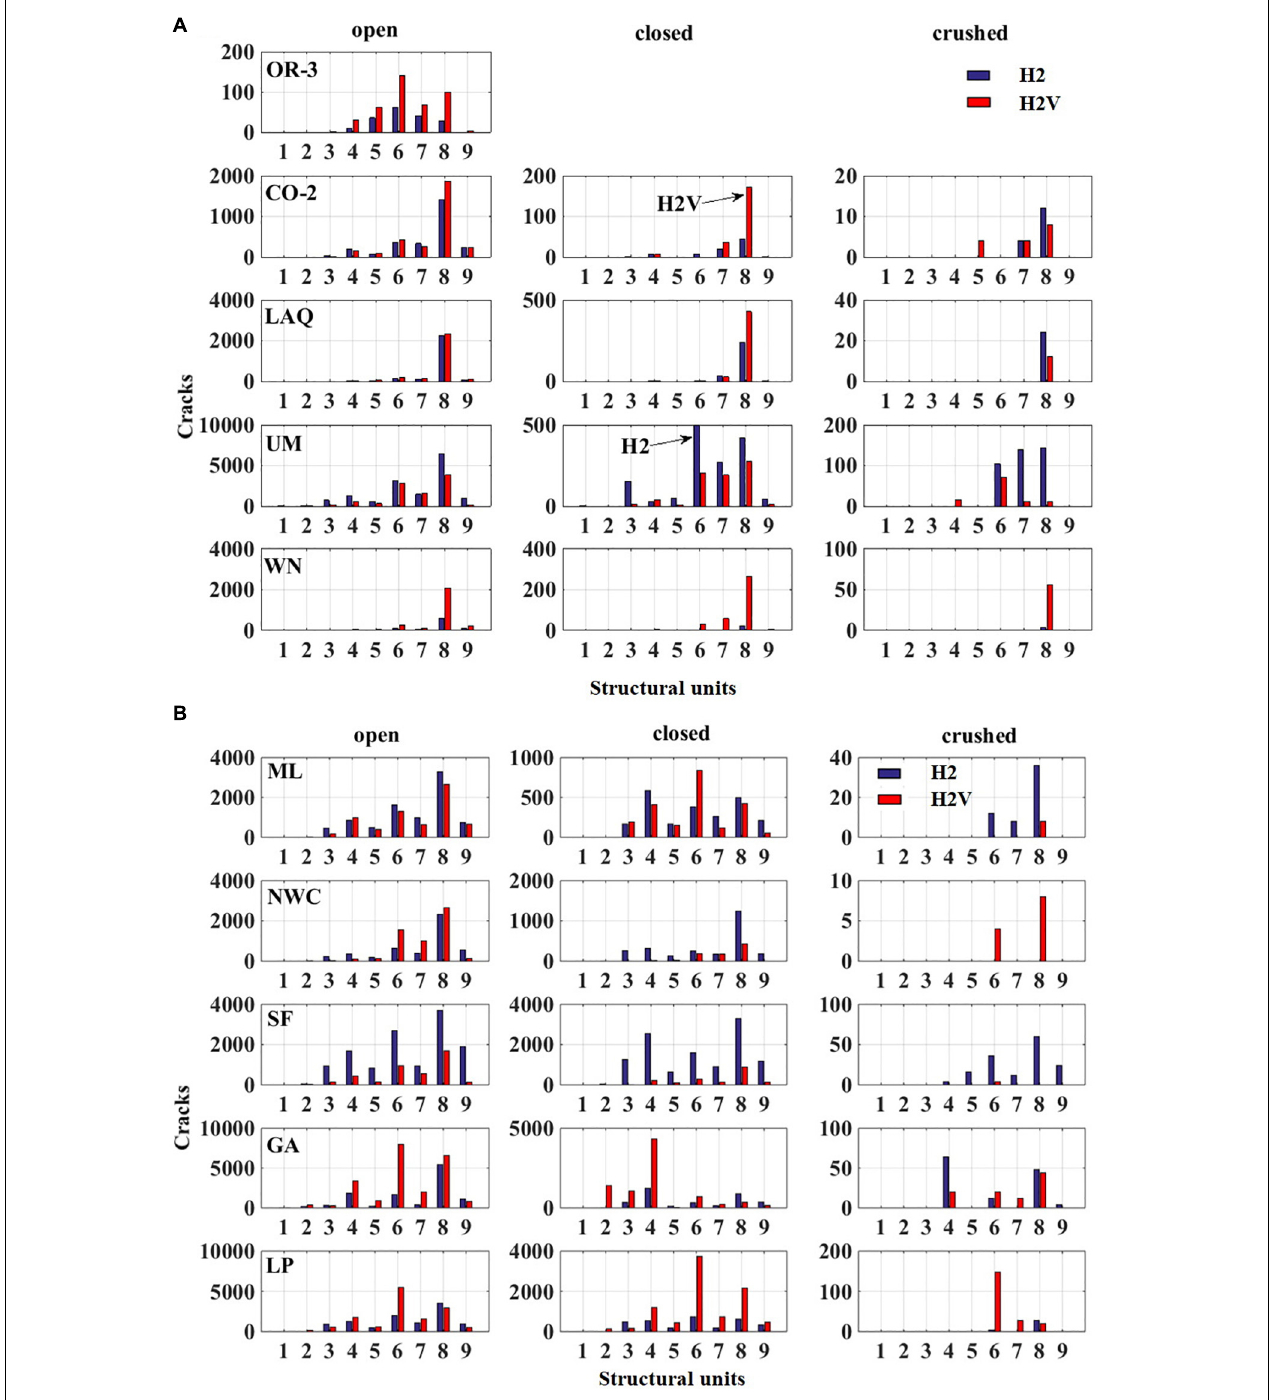
FIGURE 7 | (A) Spatial distribution of different crack types, events 1–5. (B) Spatial distribution of different crack types, events 6–10.